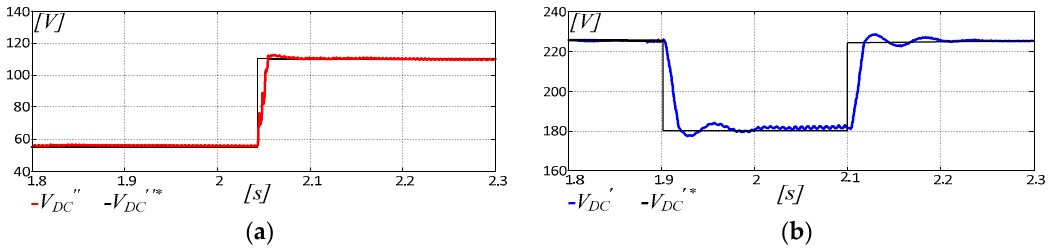
Figure 17. SimPower System model. One-time variation of V DC ' and V DC '' references. ( a ) TLI DC bus voltage V DC ''. ( b ) Output voltage V DC ' .